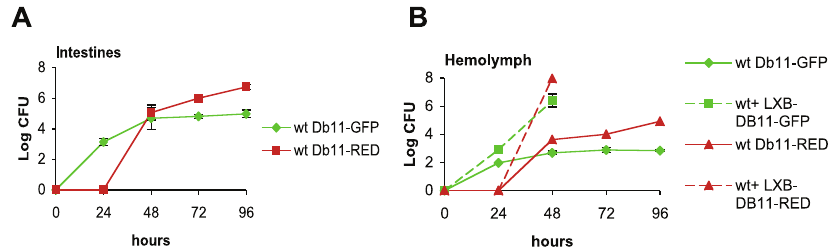
Figure 8. The Increasing Number of Db11 in the Hemolymph Results from Bacterial Passage from the Gut (A, B) Flies were fed for 24 h on Db11-GFP bacteria and then transferred to a vial containing only Db11-DsRed bacteria. The number of GFP- and DsRed- expressing bacteria was counted in the intestine (A) and in the hemolymph of latex bead–injected and nontreated surviving flies (batches of 20 flies) (B). The counts were performed only up to 48 h in the case of LXB-treated flies since most were dead by 72 h. CFU: colony-forming units (log scale).